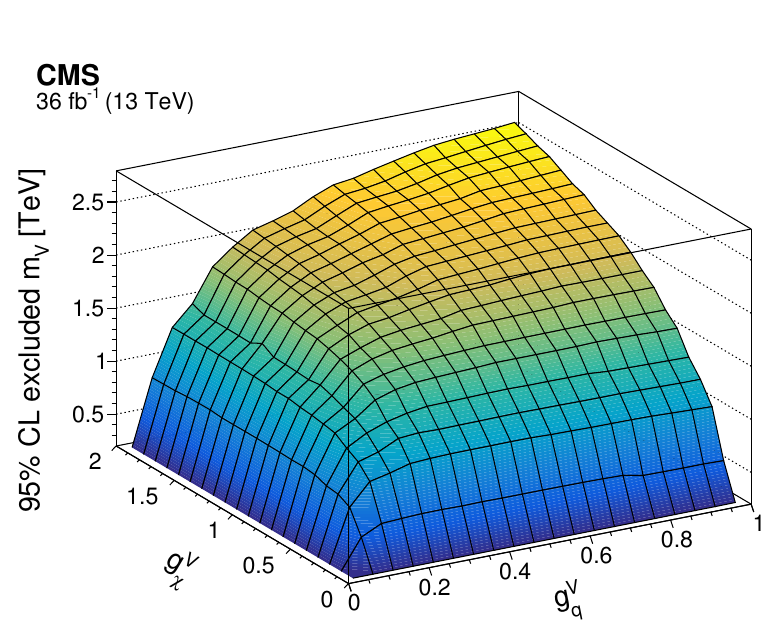
Figure 20 . The maximum excluded mediator mass at 95% CL as a function of vector couplings to DM and quarks. This plot (cid:12)xes m (cid:31) = 1 GeV and g A given su(cid:14)ciently large coupling choices.